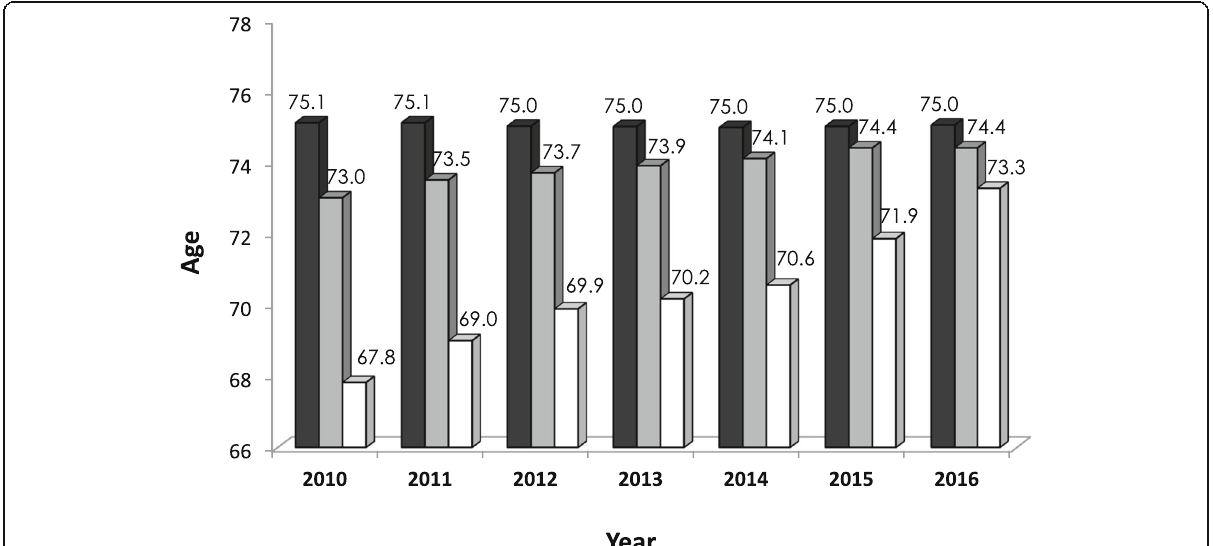
Fig. 1 Mean age of all patients with ischemic stroke (black), treated with intravenous (grey) thrombolysis and mechanical thrombectomy (white) in Germany from 2010 to 2016